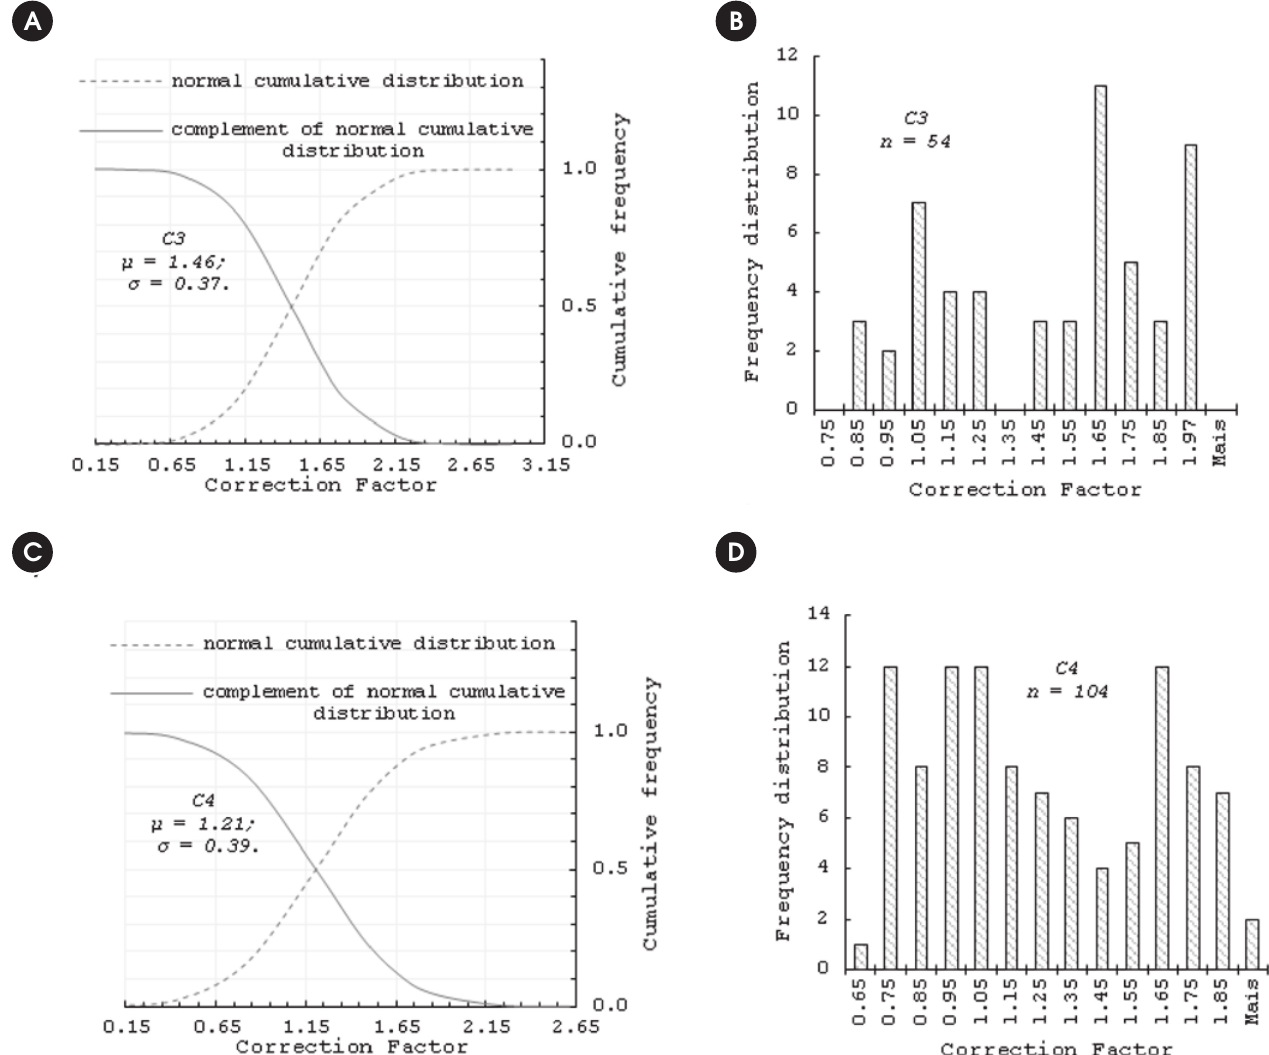
Figure 8 Cumulative Gaussian distribution curve and frequency distribution for the correction factors of concretes C3 and